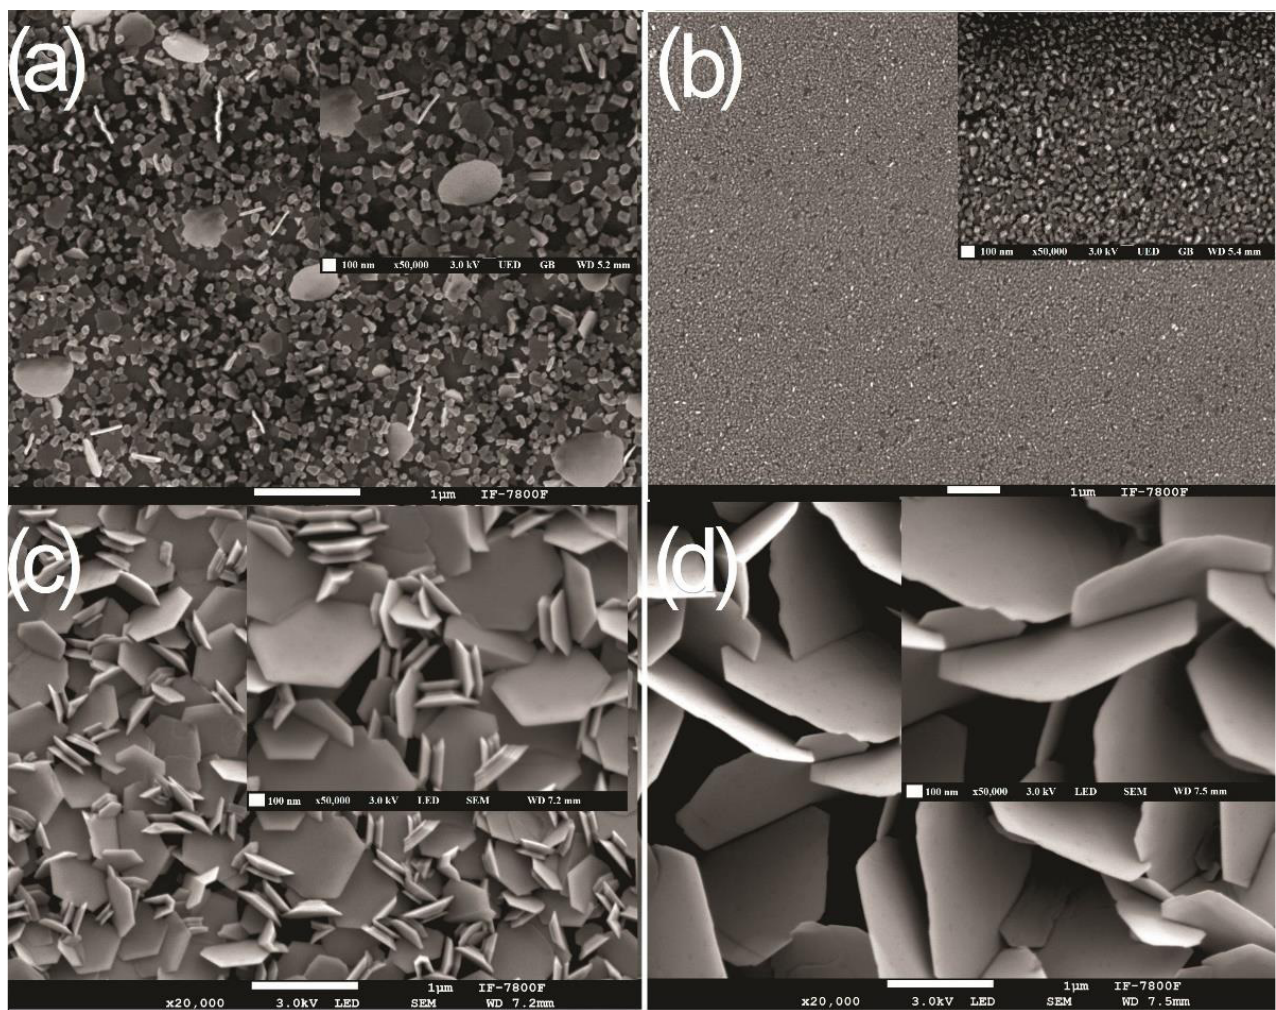
Figure 3. Micrographs of the Zn films, obtained with SEM under a fixed resolution ( × 50,000 for the inset figures). Four different samples with different average particle sizes: ( a ) A1 (50 nm); ( b ) 3 M (250 nm); ( c ) 6 M (350 nm); ( d ) 10 M (850